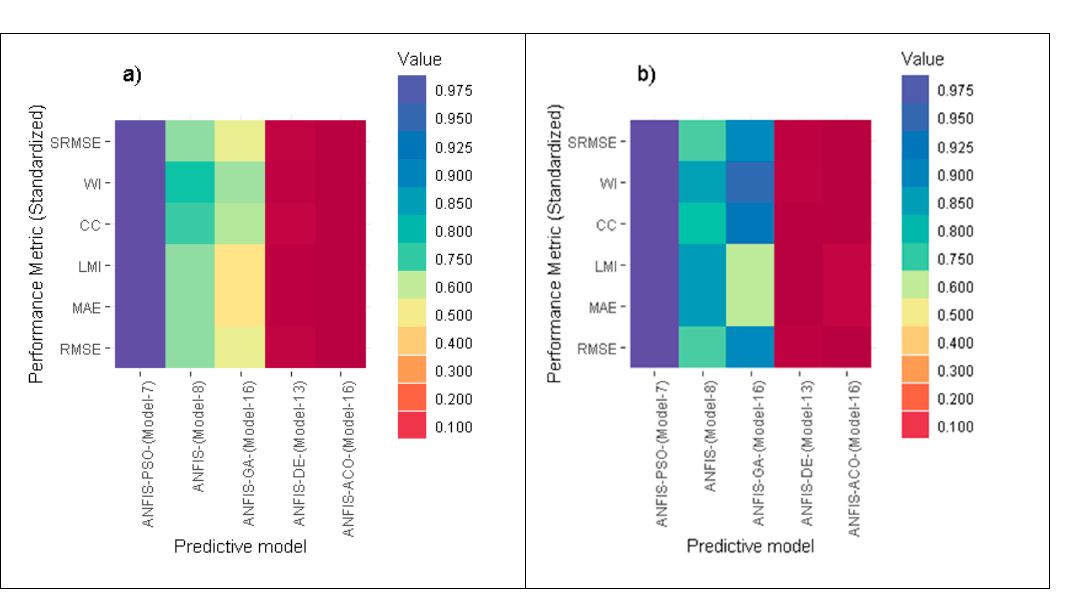
Figure 3. Heat map of the applied hybrid predictive models: ( a ) Training stage and ( b ) Testing stage.